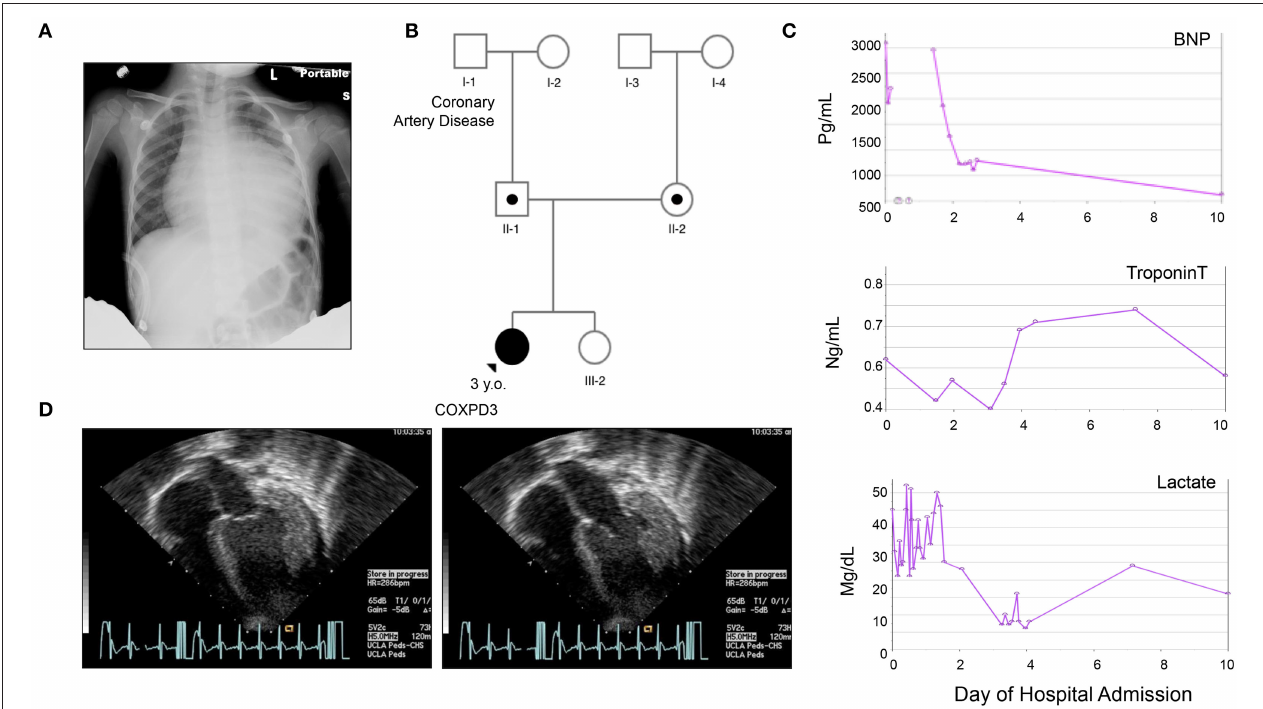
FIGURE 1 | Clinical Presentation of the Proband. (A) Chest X ray on admission demonstrating severe cardiomegaly. (B) Three-generation family pedigree: III-1, Index case; II-1, father carries the c.355G > C (p.Val119Leu) variant; II-2, mother carries the c.997C > T (p.Arg333Trp) variant. III-2, older healthy sister that has not been tested; No other family history of heart disease besides [I-1], grandfather with coronary heart disease. (C) Graphs representing summary of serum brain-natriuretic peptide (BNP), cardiac Troponin T, and Lactate levels during the first 10h after admission. (D) Representative echocardiogram, apical views on admission during systole (a) and diastole (b) demonstrating global left ventricular hypokinesis with estimated EF of 10–15%, significant concentric hypertrophy of the left ventricle, normal coronary arteries take offs, circumferential effusion without chamber compression measuring 14mm posterior and 8mm anterior, mild mitral regurgitation. *Please see accompanied Supplementary Videos included in Supplementary Materials